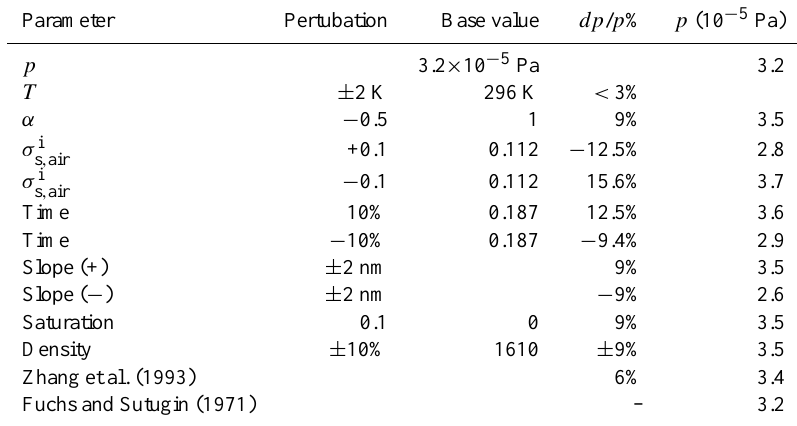
Table 3. Sensitivity analysis of the vapor pressure results for 2-oxoglutaric acid.